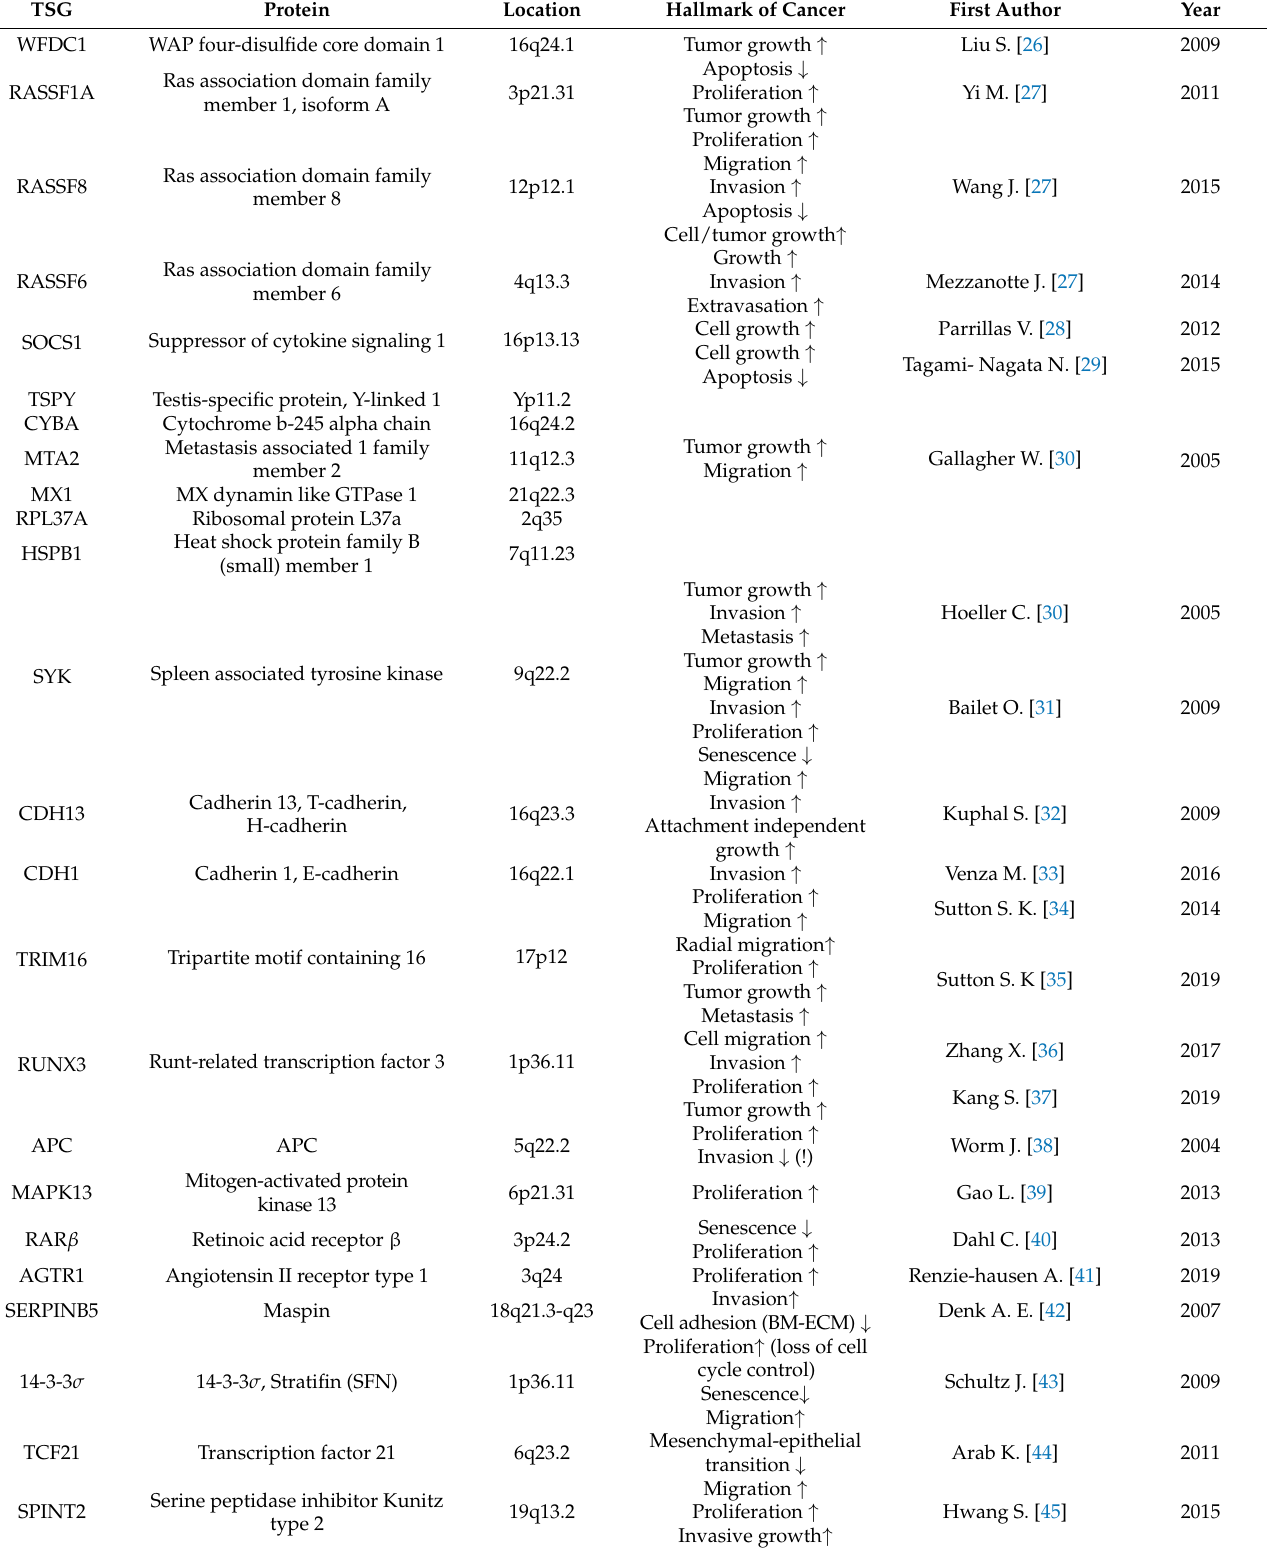
Table 1. Bona fide tumor suppressor genes methylated in